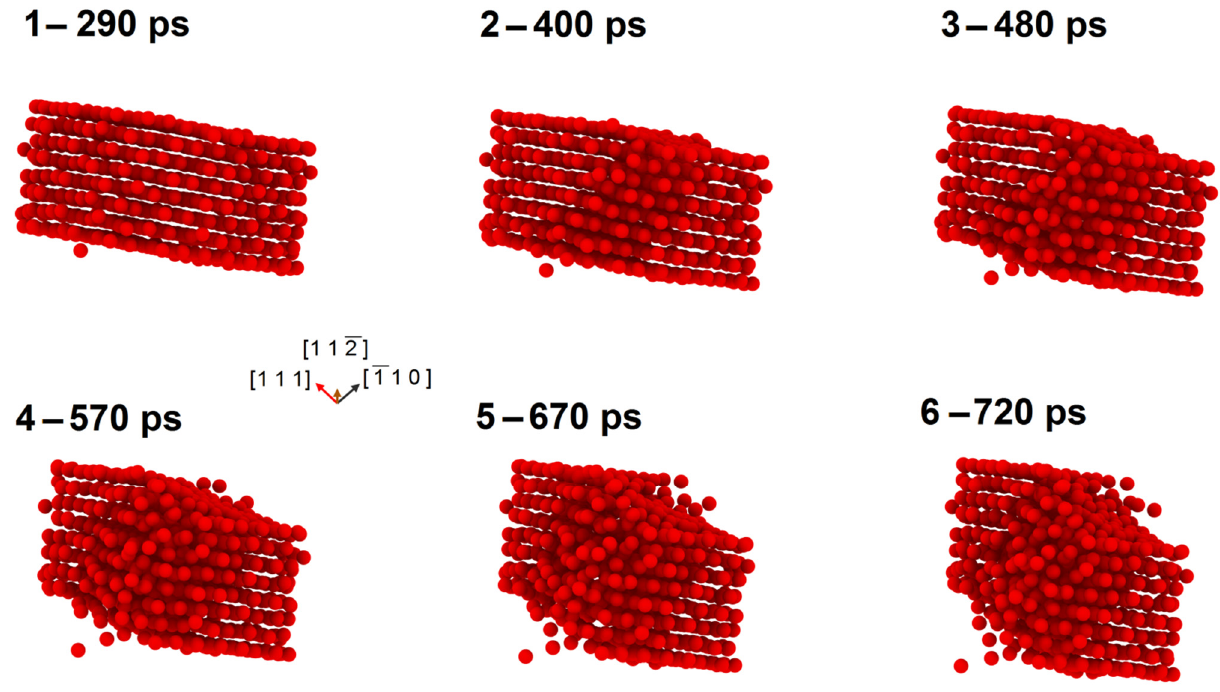
Figure 6. View of θ ’ precipitate after several interactions with dislocation; interaction number is indicated above each view together with the corresponding time. Diameter of θ ’ phase is 5 nm; shear velocity is 5 m/s; and temperature is 300 K. Only copper atoms are shown.